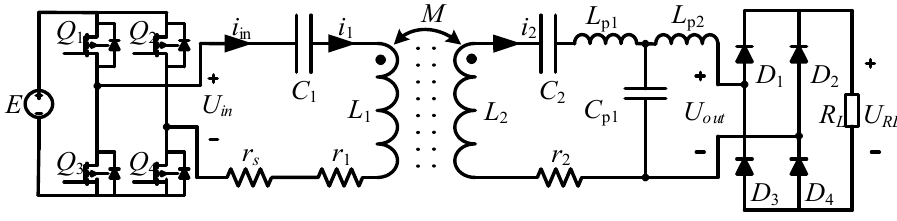
Figure 4. S-LCL compensated 2-coil system from [22].